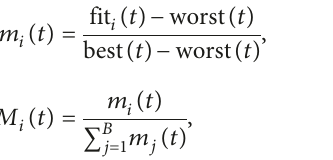
represents the kernel parameter p of RVM, and L − ( l + u ) denotes the length of the binary code string representing the kernel parameter p of RVM.